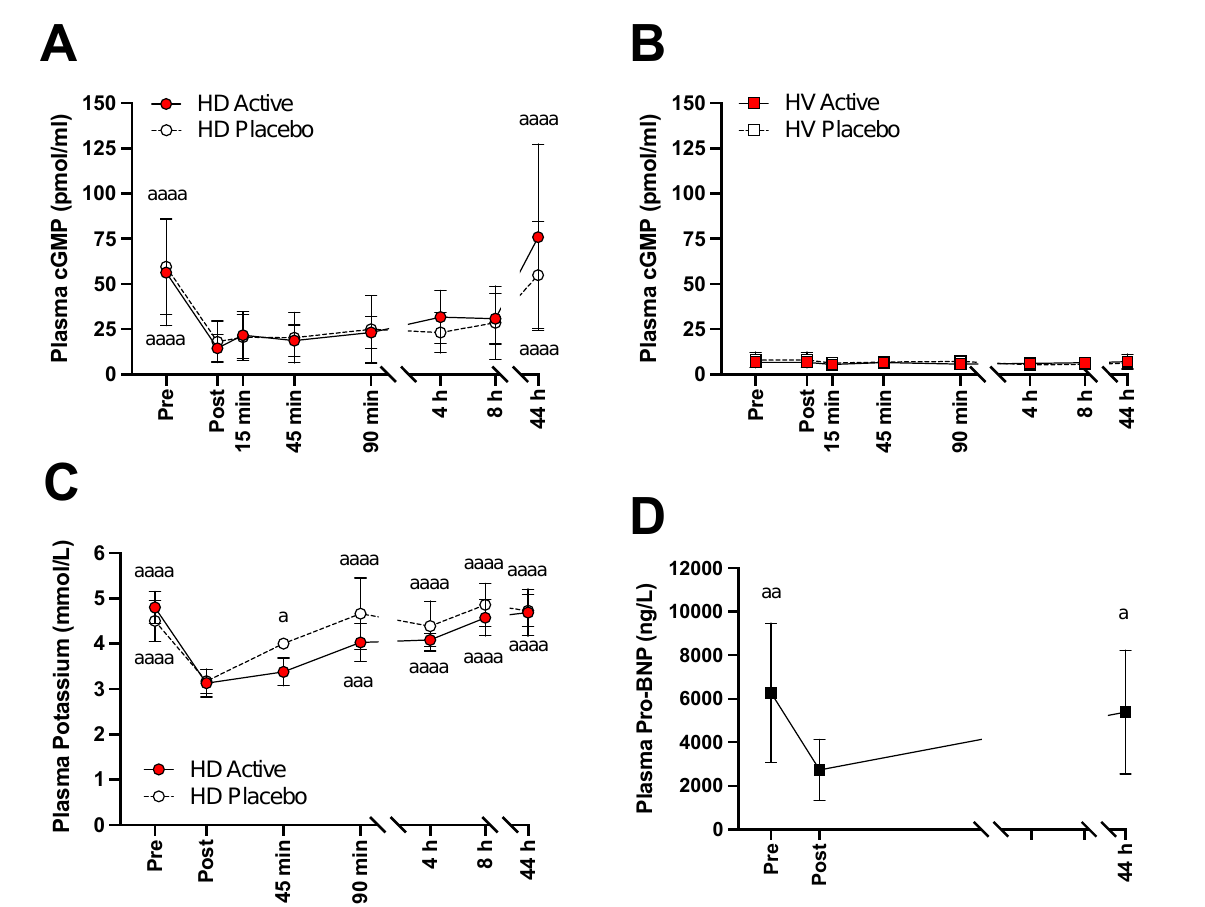
Figure 2. Plasma levels of cGMP, potassium, and pro-BNP after single ingestion of nitrate-enriched (Active) and nitrate-depleted (Placebo) beetroot juice (BJ) in hemodialysis patients and in healthy volunteers. Legend: Plasma cGMP levels in hemodialysis patients (HD, Panel ( A )) and in healthy volunteers (HV, Panel ( B )) after active BJ (filled red) or placebo BJ (open white) ingestion, respec- tively. Plasma potassium levels ( C ) in HD patients after active BJ (filled red) or placebo BJ (open white). Plasma pro-BNP levels ( D ) in HD patients without having received either active or placebo BJ. HD, hemodialysis patients; HV, healthy volunteers; pro-BNP, N-terminal pro-brain natriuretic peptide. Values are presented as mean and standard deviation. a p < 0.05; aa p < 0.01; aaa p < 0.001; aaaa p < 0.0001 as compared with “post” values in HD patients and “baseline” values in the HV, before active BJ and placebo BJ ingestion, respectively. Pro-BNP normal reference values: Healthy adults up to 74 yr: ≤125 pg/mL; >75yr: ≤210 pg/mL. Healthy population 97.5 percentile: <44 yr: 125 pg/mL; 45 – 54 yr: 172 pg/mL; 55 – 74 yr: 350 pg/mL; >75 yr: 750 pg/mL.